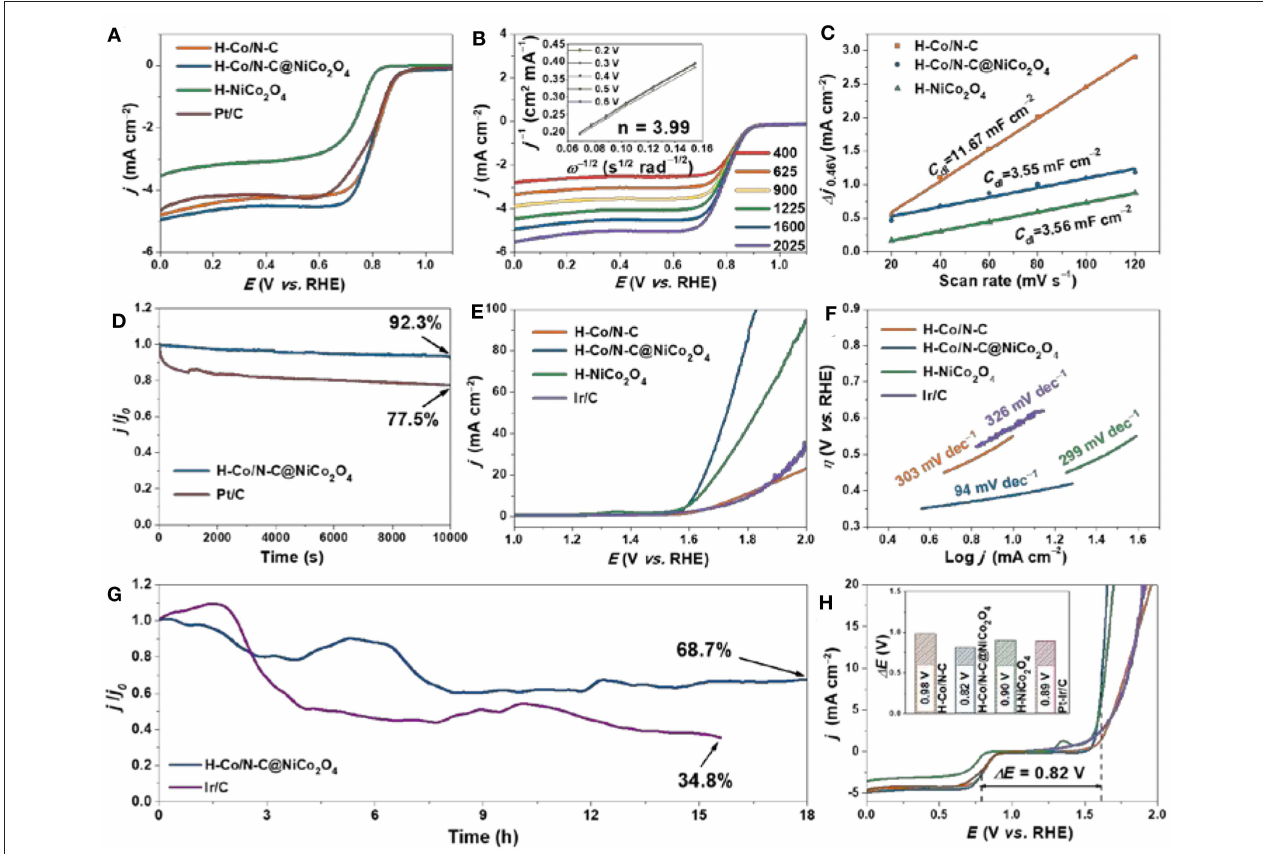
FIGURE 3 | (A) LSV curves of H-Co/N-C, H-Co/N-C@NiCo 2 O 4 , H-NiCo 2 O 4 , and Pt/C for ORR. (B) LSV curves for H-Co/N-C@NiCo 2 O 4 at various rotation rates. The inset is the corresponding Kouteck–Levich plots for H-Co/N-C@NiCo 2 O 4 at various potentials calculated from RDE data. (C) C dl of H-Co/N-C, H-Co/N-C@NiCo 2 O 4 , and H-NiCo 2 O 4 calculated from current density difference ( 1 j = j a – j c ) plotted vs. scan rate. (D) Amperometric i–t curves of H-Co/N-C@NiCo 2 O 4 and Pt/C for ORR. (E) LSV curves and (F) Tafel slopes of H-Co/N-C, H-Co/N-C@NiCo 2 O 4 , H-NiCo 2 O 4 , and Ir/C for OER. (G) Amperometric i–t curves of H-Co/N-C@NiCo 2 O 4 and Ir/C for OER. (H) Overall LSV curves of the ORR and OER for H-Co/N-C, H-Co/N-C@NiCo 2 O 4 , H-NiCo 2 O 4 , Pt/C, and Ir/C. The inset is 1 E for H-Co/N-C, H-Co/N-C@NiCo 2 O 4 , H-NiCo 2 O 4 , and